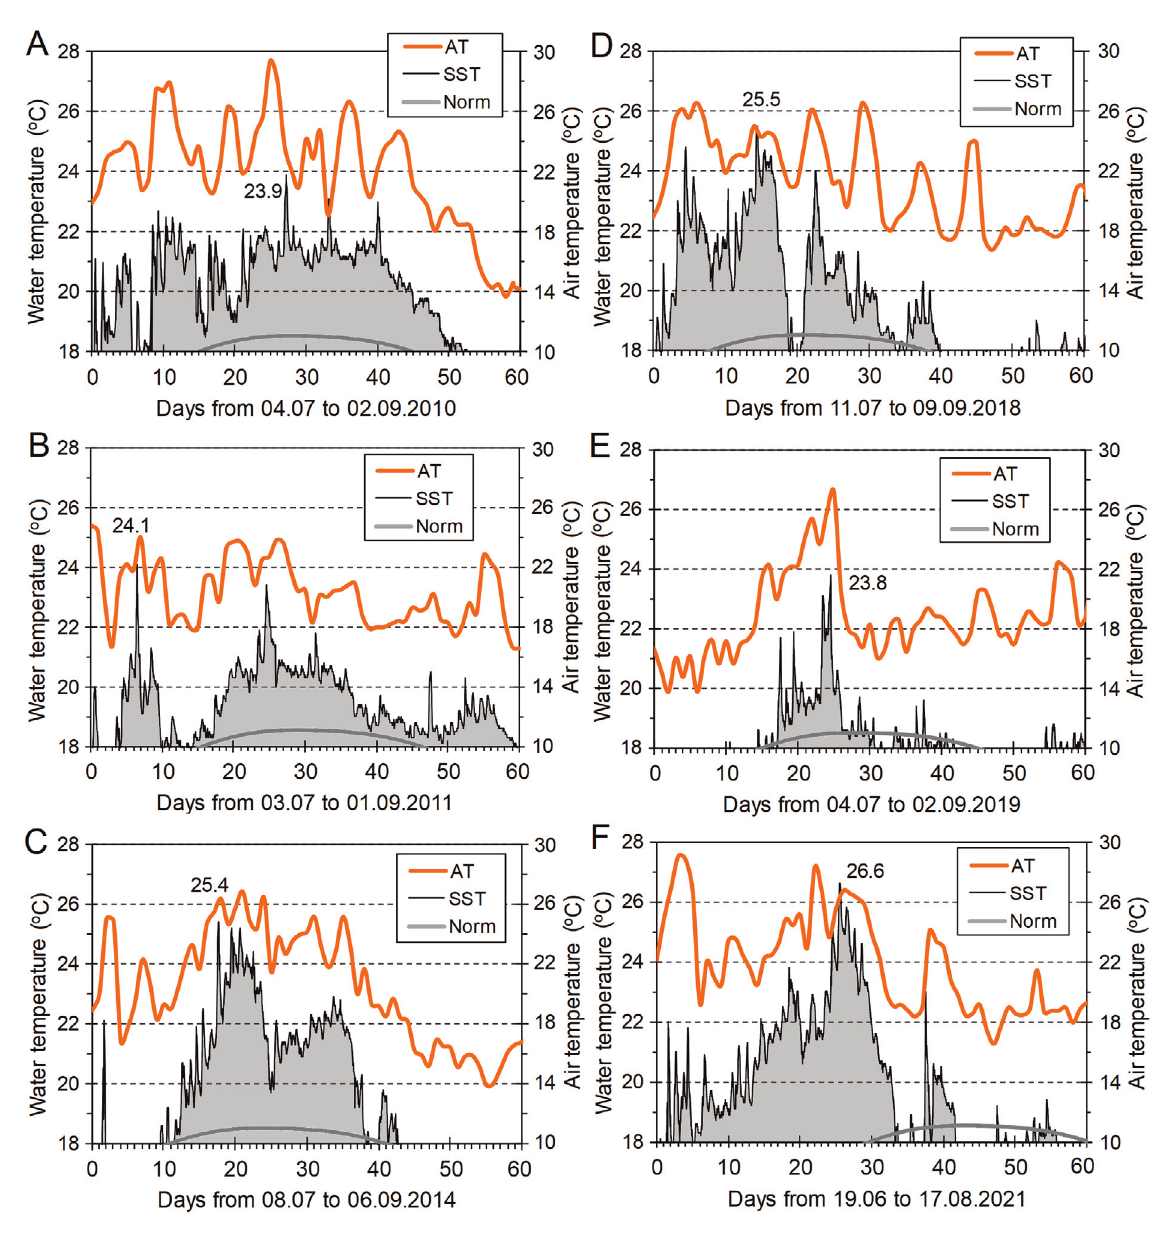
Fig. 6. Comparison of time series of air temperatures (AT; at the Porvoo Kalbådagrund station – PKS) and water temperatures (SST; at the Gulf of Finland wave buoy – GWB) together with the GWB ‘norm’ (2005–2021 average) in selected years. Annual SST peak values are indicated on graphs. The series begin when SST exceeds 18 °C for the first time (except in E ) and spans equally for 60 days. Grey fill (integral) over the 18 °C base illustrates aspects of both the duration and magnitude of the MHWs and helps to compare the events. As the PKS data are missing for 2019, AT data from the nearby Helsinki Lighthouse are used in ( E